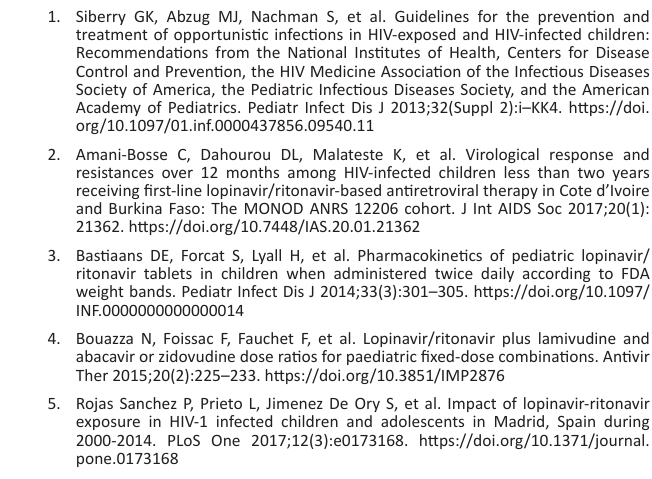
TABLE 1: Plasma concentrations of liquid lopinavir and ritonavir in samples, mixed with formula milk, glucose syrup or glucose syrup plus ethanol. Oral solution